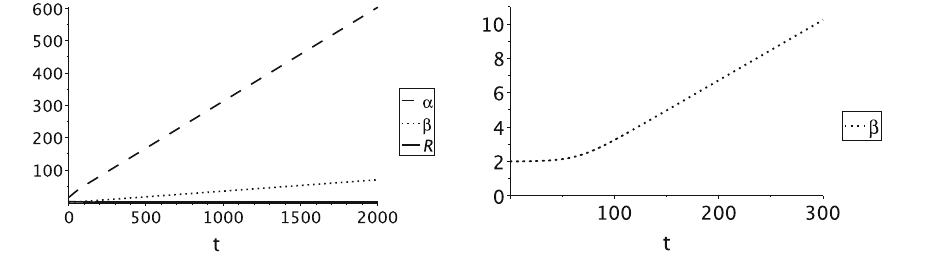
Fig. 2 Numerical solution to the system of equations (8), (9) and (10) for initial conditions α( 0 ) = 15 , β( 0 ) = 2 , ˙ α( 0 ) (cid:4) 0 . 4046668 , ˙ β( 0 ) = 0 , ˙ R ( 0 ) = 0. R ( 0 ) (cid:4) 2 . 0912618 is found from